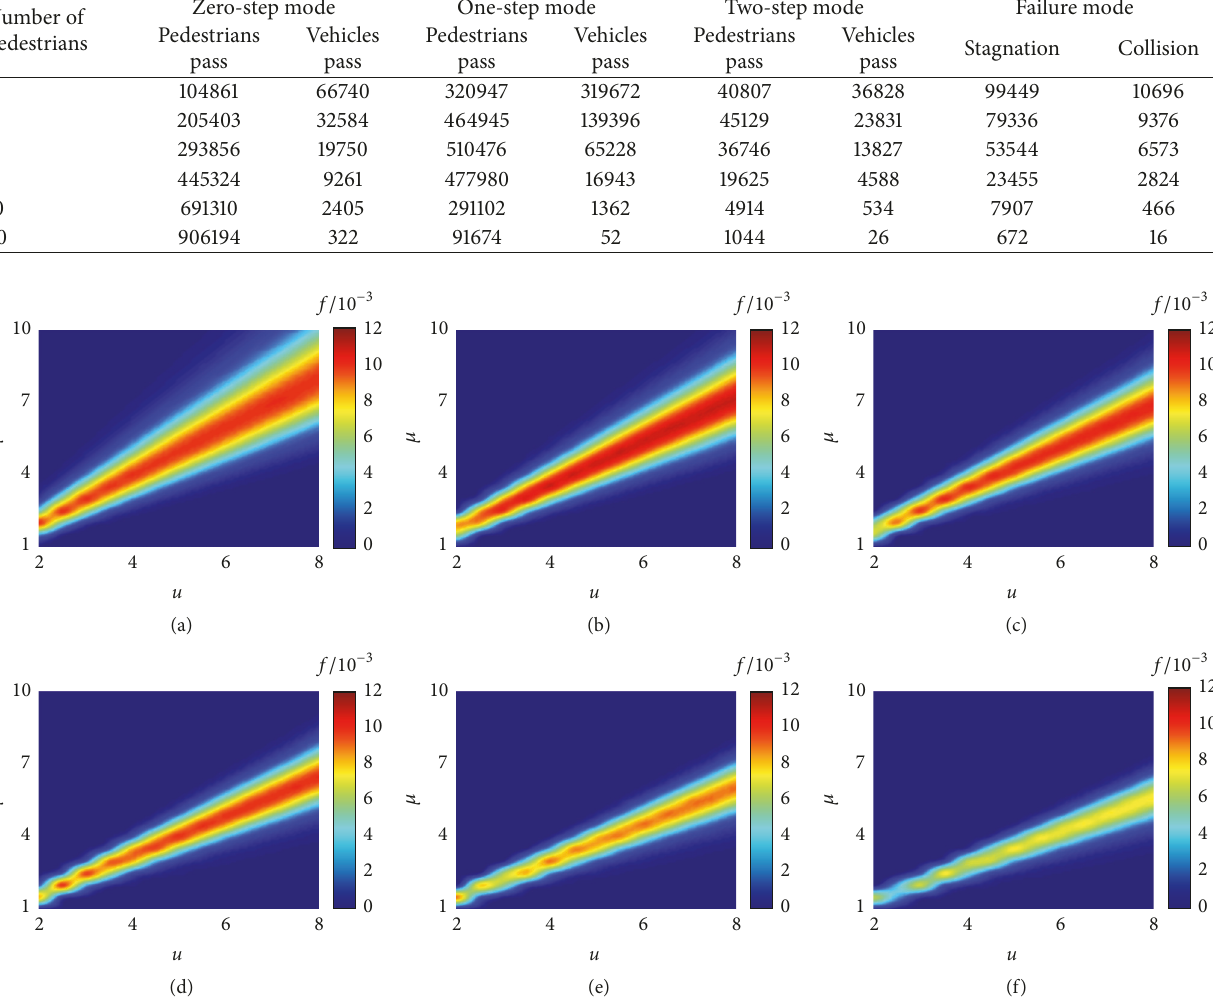
Figure 2: The effect of the group size on the conflict probability in consideration of the heterogeneity of the waiting time (the number of pedestrians is 1, 2, 3, 5, 10, and 20, from (a) to (f) graph). 𝑘 𝑖 = 𝑘 ∗ 𝑖 = 0.15 , 𝑙 = 𝑙 ∗ = 0.15